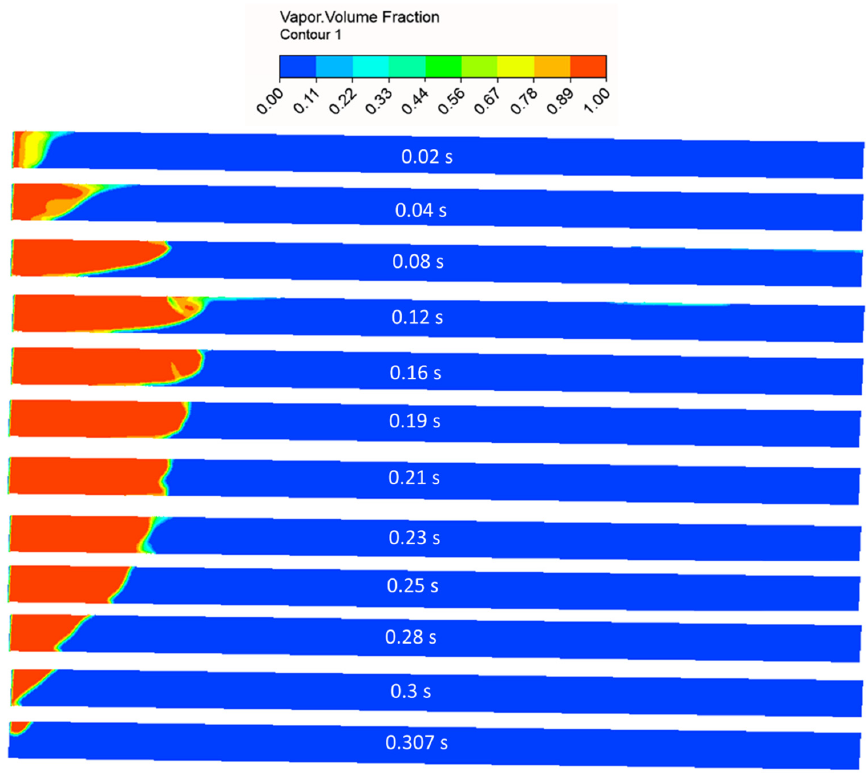
Figure 7. Cavity size evolution captured by Figure 7. cavity size evolution captured by 1D-2D.